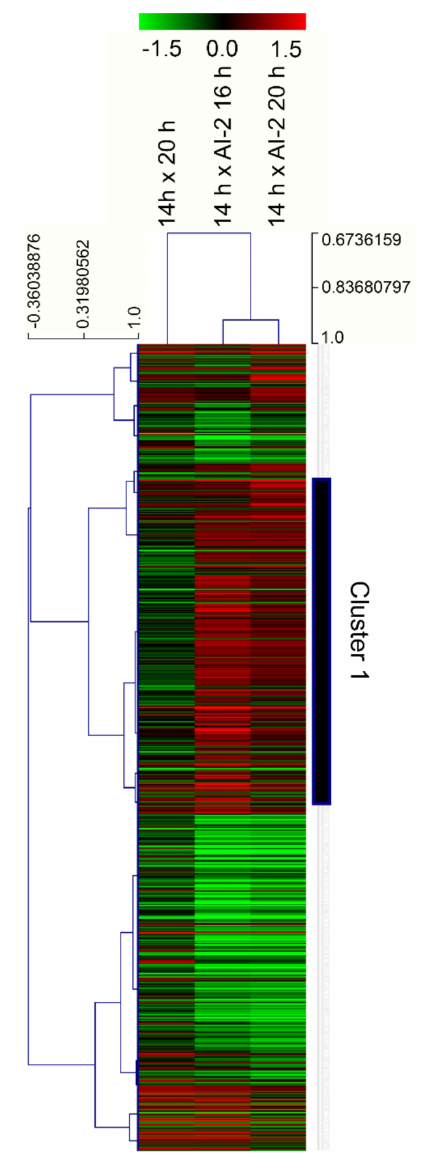
Figure 2. Gene expression patterns of Z. mobilis cultures, in response to the presence of AI-2 and different growth phases. The gene expression patterns shown above were obtained through RNA-seq experiments, employing samples obtained from the different timepoints depicted in Figure 1. RNA obtained from cells grown for t = 14 h (exponential growth phase) was used as a common reference for transcriptome comparisons with cells grown for t = 20 h (stationary phase), as well as cells induced to early stationary phase, due to the presence of 45 µ M AI-2 (t = 16 h + AI-2 and t = 20 h + AI-2). The figure shows the average values for each of the 724 genes identified as modulated during three relative comparisons [log 2 (t = 20 h /t = 14 h), Log 2 (t = 16 h + AI-2/t = 14 h) and log 2 (t = 20 h + AI-2/t = 14 h)] (see Materials and Methods for details). The genes and experimental conditions were subjected to a hierarchical clustering algorithm and visualized with the aid of TMEV [11]. Genes highlighted in Cluster 1 show an expression pattern that differentiates cells treated with AI-2 from those that spontaneously entered stationary phase (see text for